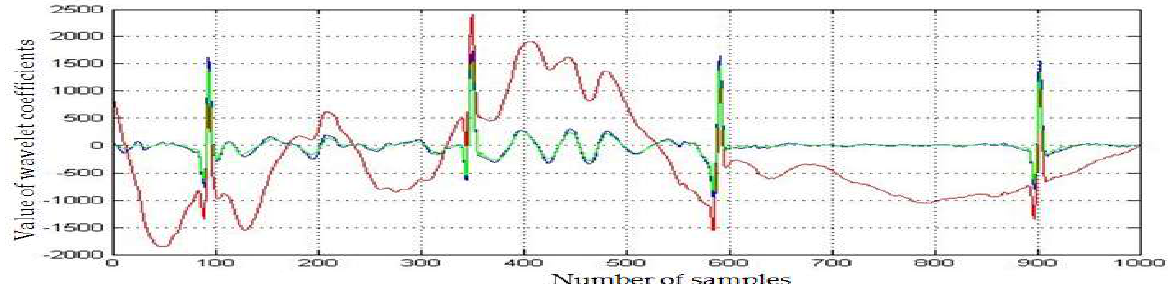
Table 1. Performance of RR peak detection wavelet algorithm for the preterm infants ECGs. Figure 5. Superposition of original ECG (red color), ECG with reduced baseline drift (blue color) and denoised ECG (green color), for infant6_ecgm .